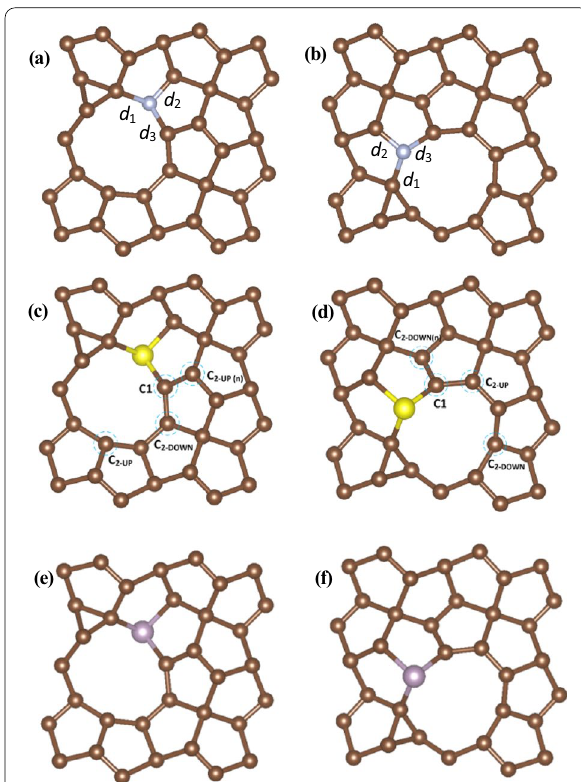
Fig. 3 The optimized structures for the defect and doped PG with the two different C2 vacancy sites, a V C-UP N-doped, b V C-DOWN N-doped, c V C-UP S-doped, d V C-DOWN S-doped, e V C-UP P-doped, f V C-DOWN P-doped, the blue dashed circles indicate possible active sites for hydrogen evolution